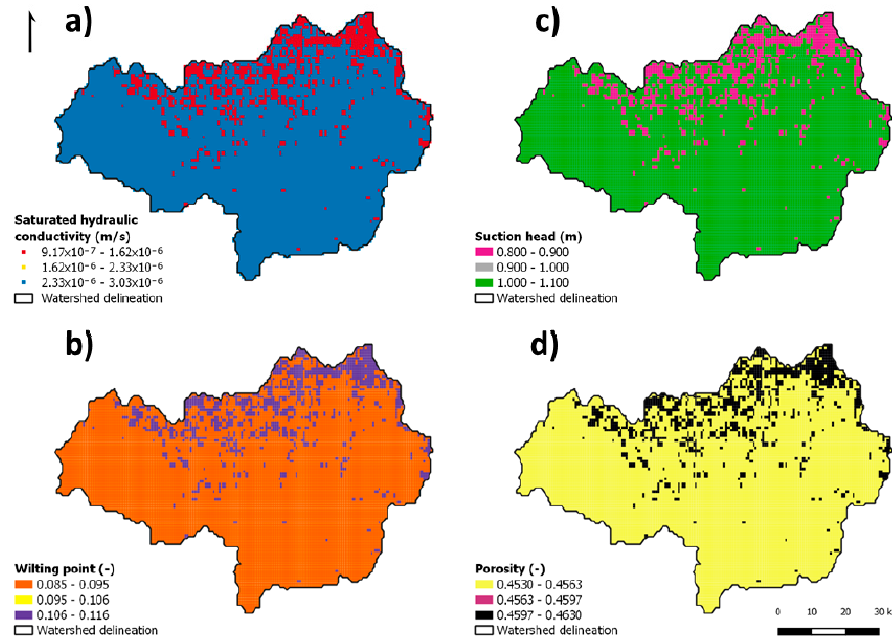
Figure 6. Parameters used in the Green and Ampt model: ( a ) saturated hydraulic conductivity; ( b ) wilting point; ( c ) suction head; ( d ) soil porosity.